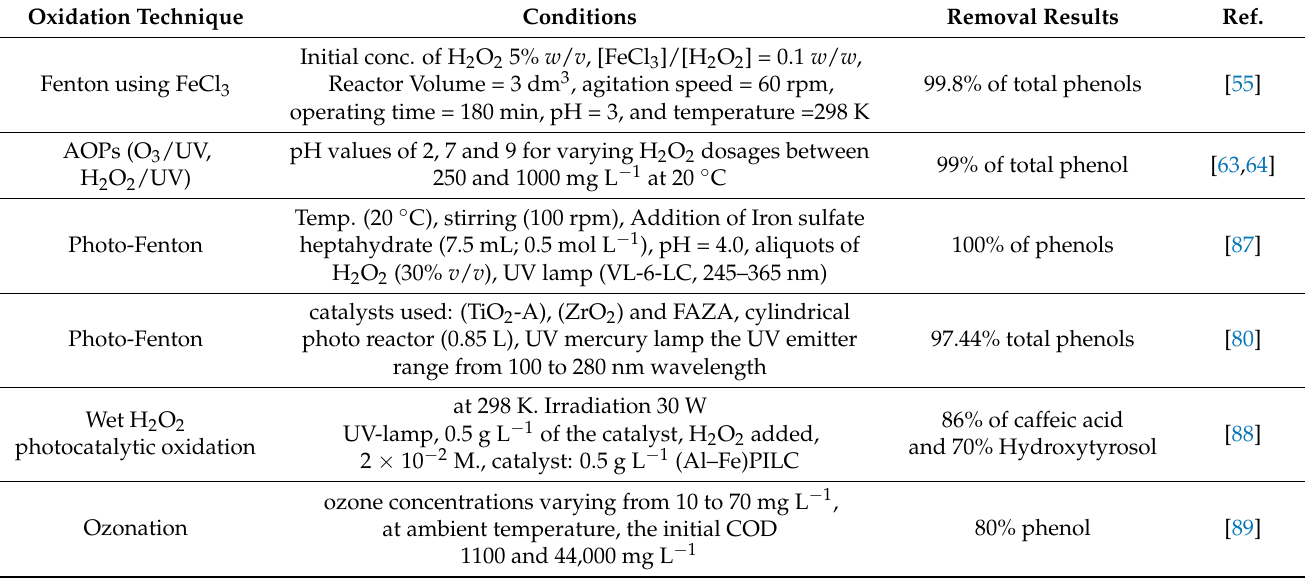
Table 5. Summary of oxidation techniques for OMW treatment. Adapted from Reference [86]. Conditions Removal Results